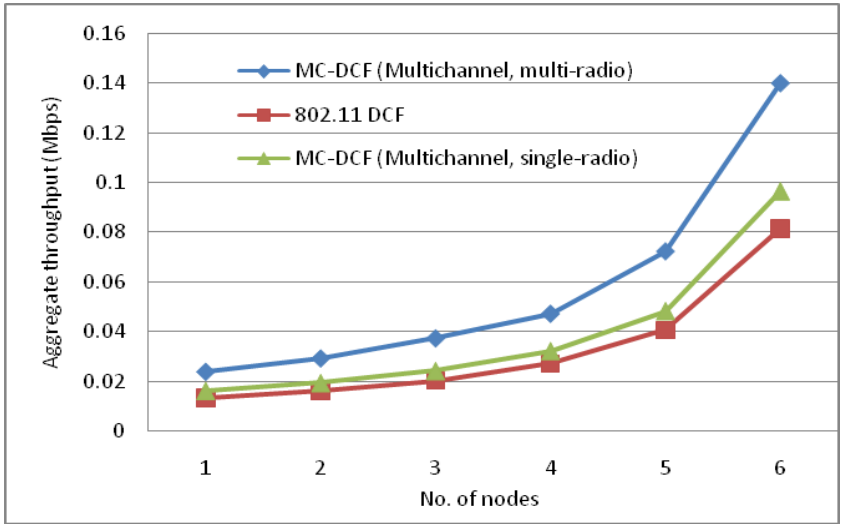
Figure 14. Throughput impact comparison with one-many communications at sink